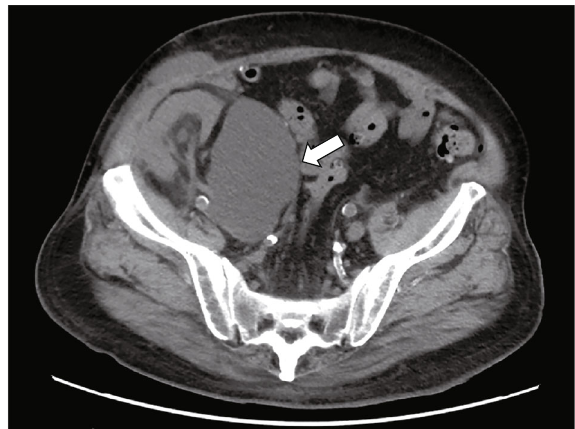
Figure 1: Computed tomography (CT). A lymphocele ( 16 cm × 8cm × 6 cm ) on the left side of the transplanted kidney in the right iliac fossa (white arrow) is